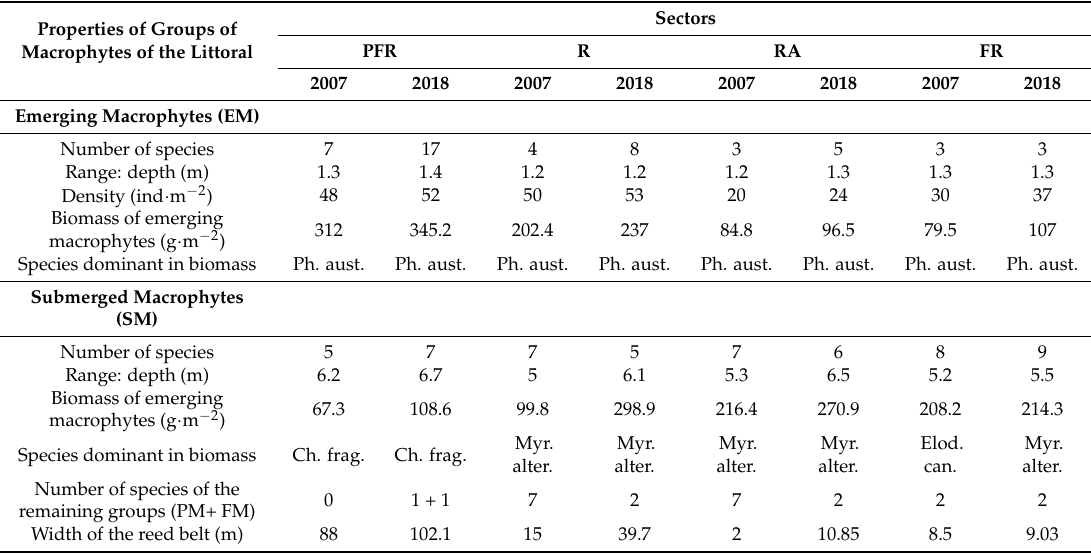
Table 10. The characteristics of particular groups of macrophytes of the littoral of Lake Piaseczno (EM, emerging macrophytes; SM, submerged macrophytes; FM, floating macrophytes; PM, pleuston macrophytes; Ph. aust., Phragmites australis , Ch. frag., Chara fragilis , Myr. alter., Myriophyllum alternifolium , Elod. can., Elodea canadensis ).